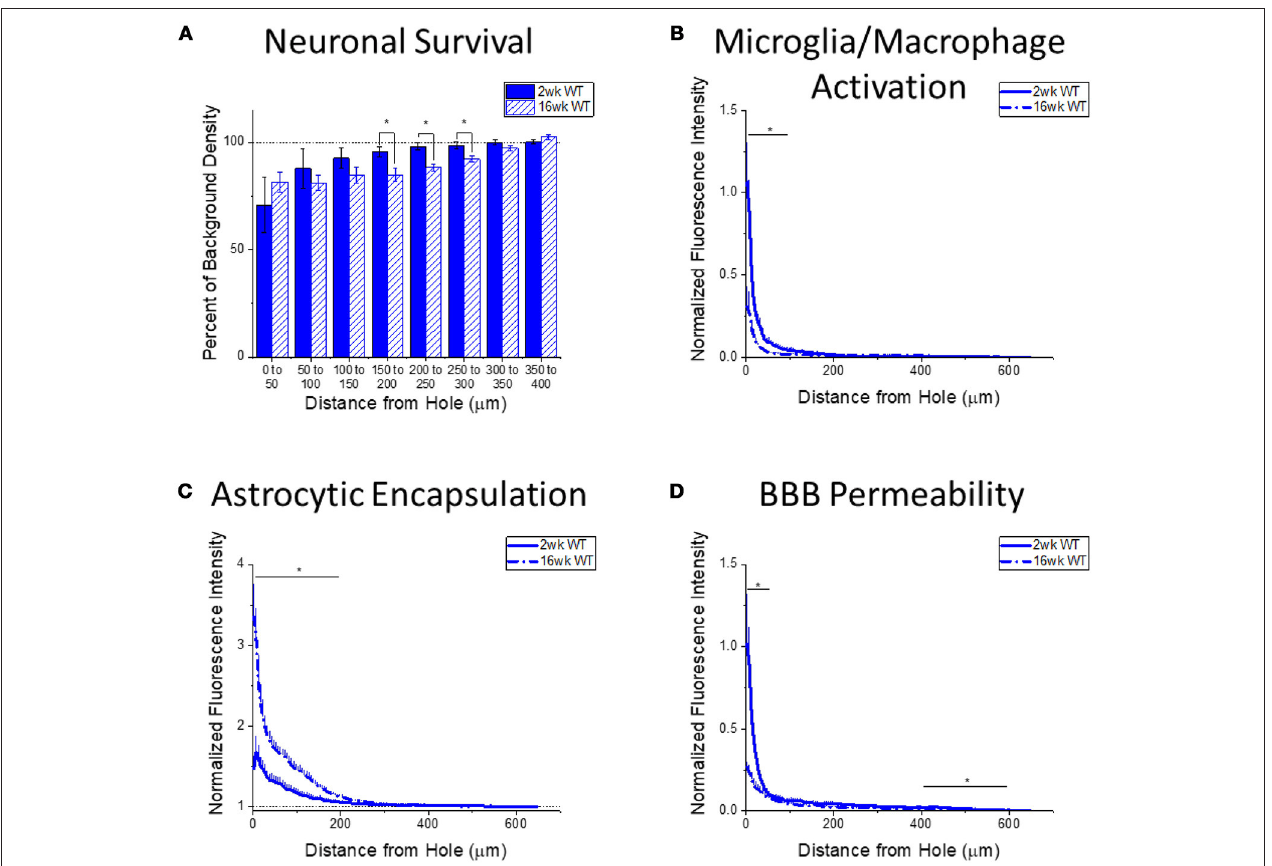
FIGURE 4 | Changes in immunohistochemical markers in wildtype mice over time. (A–D) Show immunohistochemical marker expression in WT mice at 2 and 16 weeks after probe implantation. (A) Neuronal survival displayed as percent of background neuronal density with respect to distance from the probe hole ( µ m). Wildtype mice exhibit significantly higher neuronal survival at 2 weeks after implantation in distance intervals 150–200, 200–250, and 250–300 µ m from the probe hole, * p < 0.05. 2 wk WT: N = 5; 16 wk WT: N = 7. (B) Microglia and macrophage activation (CD68) displayed as normalized fluorescence intensity with respect to distance from the probe hole ( µ m). Wildtype mice exhibited significantly higher microglia and macrophage activation at 2 weeks after probe implantation at distance intervals 0–50 and 50–100 µ m from the probe hole, * p < 0.05. 2 wk WT: N = 6; 16 wk WT: N = 7. (C) Astrocytic encapsulation (GFAP) displayed as normalized fluorescence intensity with respect to distance from the probe hole ( µ m). Wildtype mice exhibit significantly higher astrocytic encapsulation at 16 weeks after probe implantation at distance intervals 0–50, 50–100, 100–150, and 150–200 µ m from the probe hole, * p < 0.05. 2 wk WT: N = 6; 16 wk WT: N = 7. (D) Blood-brain barrier permeability (IgG) as normalized fluorescence intensity with respect to distance from the probe hole ( µ m). Wildtype mice exhibit significantly higher blood-brain barrier permeability at 2 weeks after probe implantation at distance intervals 0–50, 400–450, 450–500, 500–550, and 550–600 µ m from the probe hole, * p < 0.05. 2 wk WT: N = 6; 16 wk WT: N =